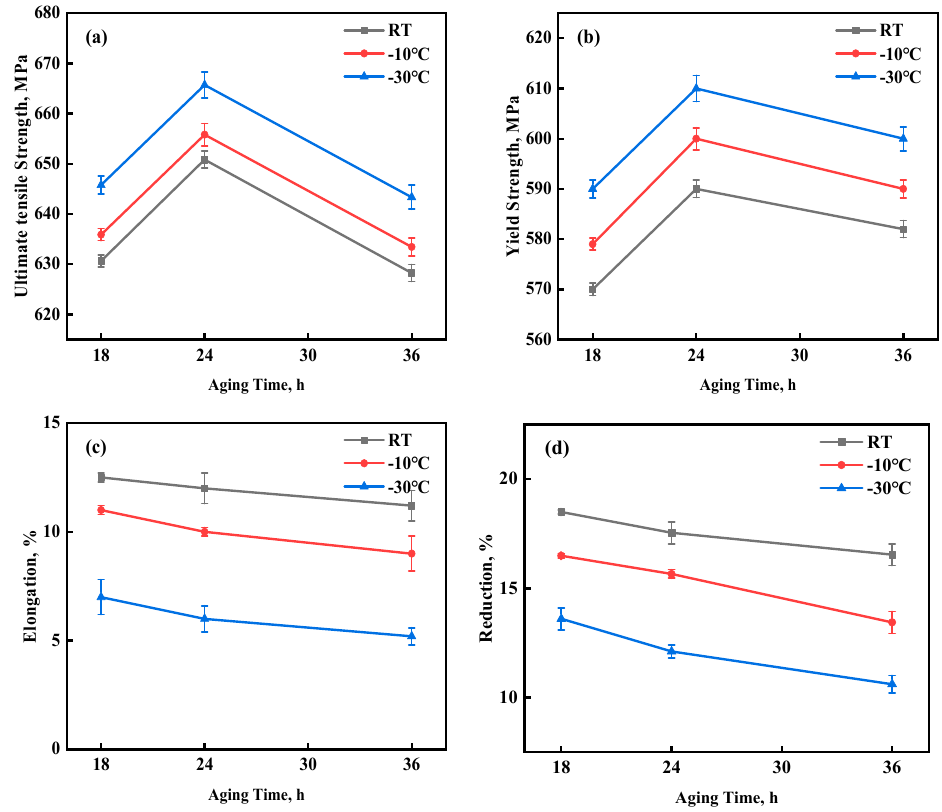
Figure 6. Mechanical properties of alloys at different experimental temperatures: ( a ) TS versus aging time; ( b ) YS versus aging time; ( c ) elongation after fracture versus aging time; ( d ) reduction after fracture versus aging time.